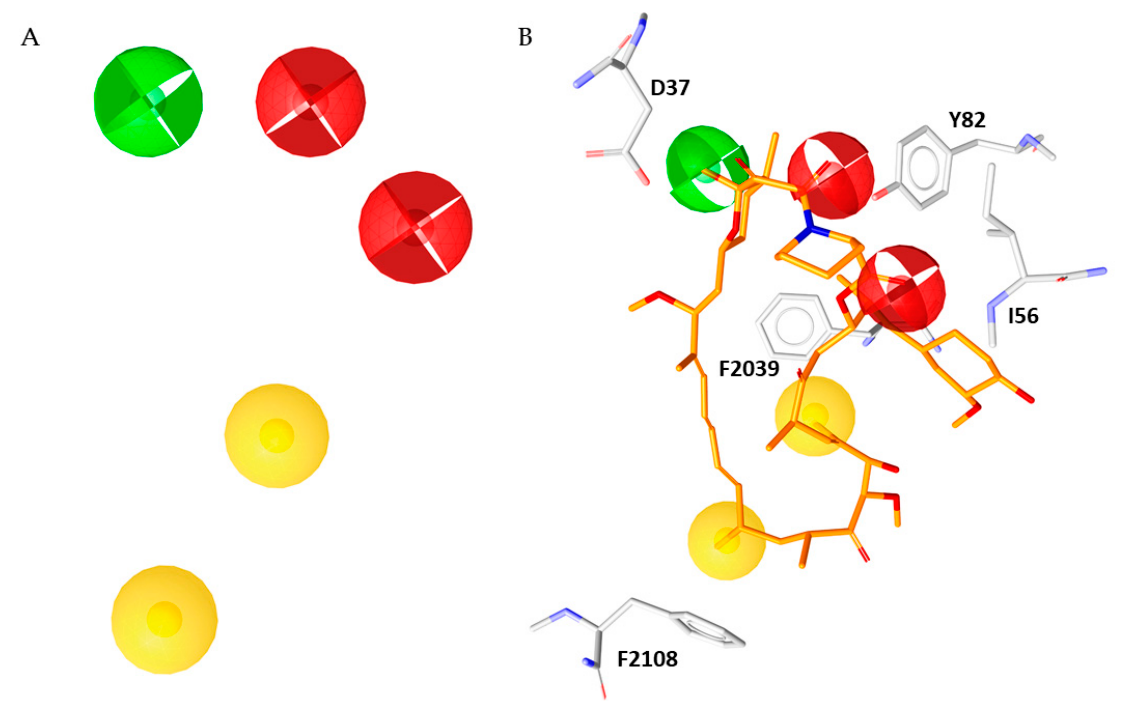
Figure 5. ( A ) Simplified five-features pharmacophore model. ( B ) Rapamycin (orange sticks) superimposed to the simplified pharmacophore model.